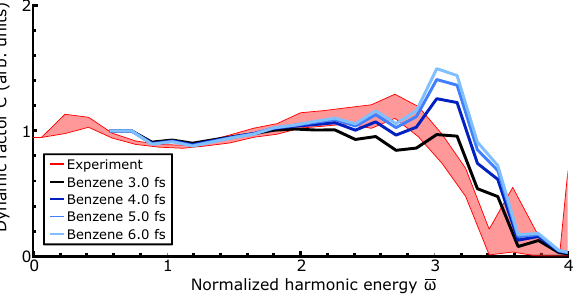
Figure 3. Dynamical factor C obtained from fitting to experimental (red) and simulated (blue-black) HHG intensity scans for benzene. The experimental shaded region for benzene represents 10–90% percentile intervals from bootstrapping the fit procedure using 6 independently recorded datasets and the simulated curves correspond to different decay constants τ as shown in the